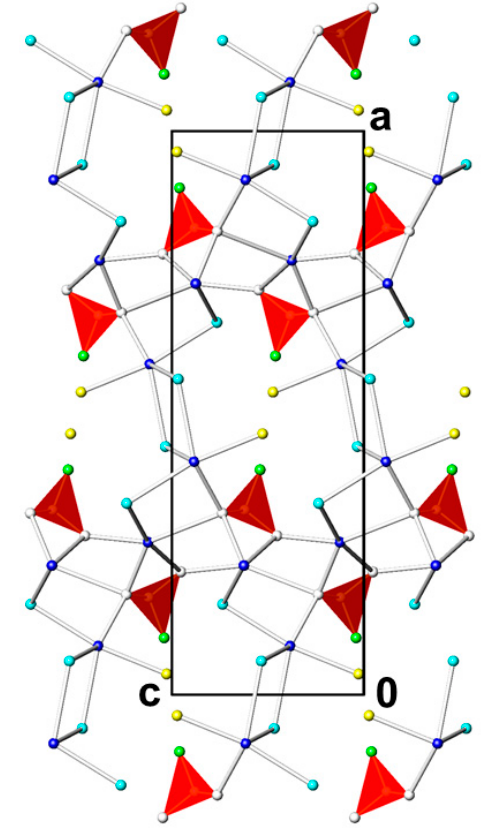
Figure 4. The crystal structure of Pb 2 (PO 3 F)Cl 2 (H 2 O) in a projection along [0-10]. Colour code of PO 3 F tetrahedra as in Figure 1; Pb atoms are represented by dark-blue spheres, Cl atoms as turquoise spheres and O atoms of the water molecules as yellow spheres.